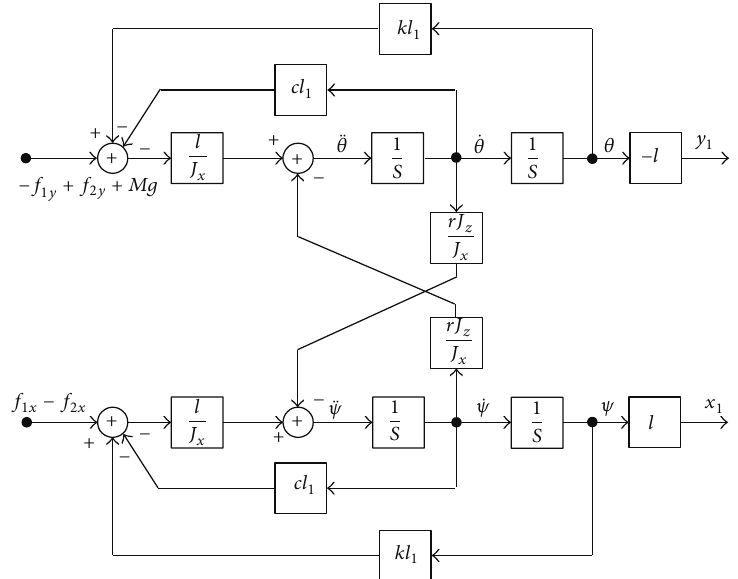
Figure 7: Diagram radial of pitching, yawing, and rolling of rotor.